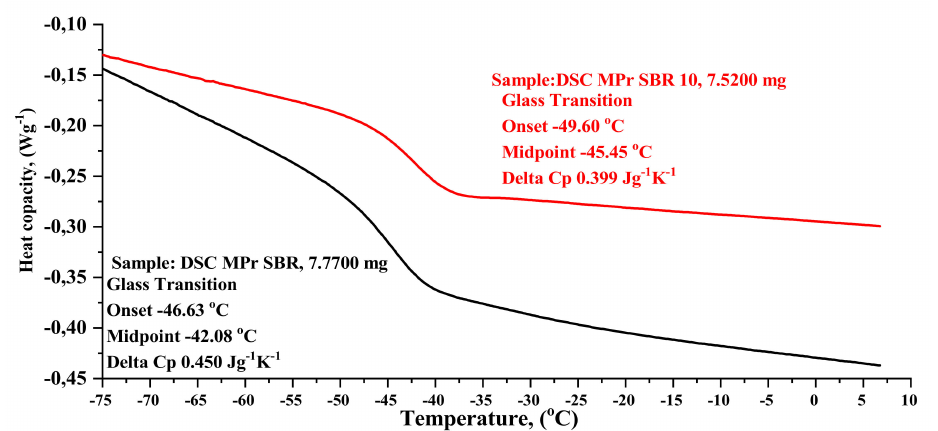
Figure 8. Thermogravimetric analysis (TGA) curves of SBR composites: reference sample SBR (black curve) and SBR10 sample (red curve).